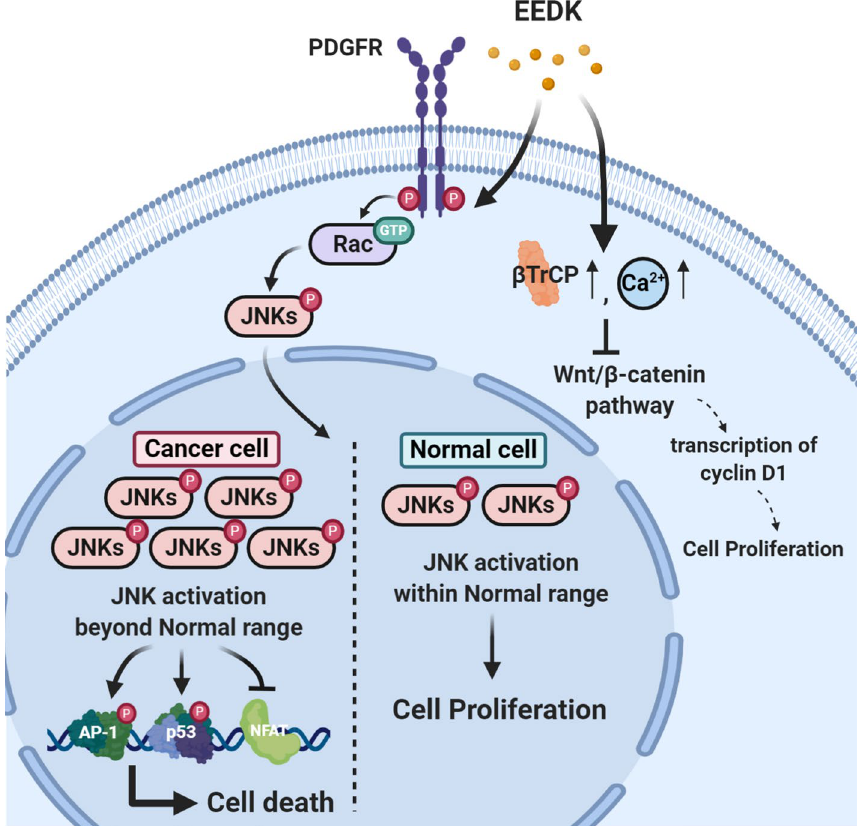
Figure 8. A proposed model of the EEDK-induced cell death pathway. EEDK could activate the PDGFR-Rac- JNK signaling axis. In cancerous cells, which have high basal JNK activity, enhanced JNK activity exceeds a normal range of JNK activation, leading to JNK-AP-1/p53 mediated cell death. However, the same amount of EEDK is not sufficient to exceed the normal range of JNK activity in normal cells, which has low basal JNK activation, resulting in cell proliferation. Besides, EEDK could suppress Wnt/β-catenin pathway by promoting βTrCP expression and intracellular Ca 2+ concentration. This figure was created using BioRender (https ://biore